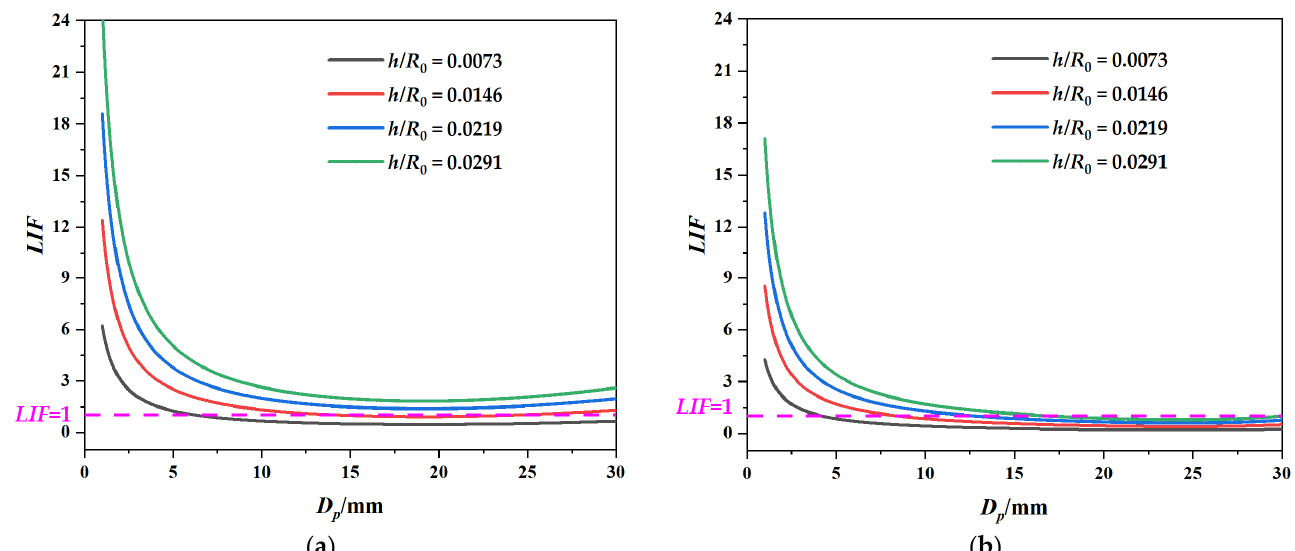
Figure 12. Pressure distribution with different h/R 0 over logarithmic spiral wall surfaces at ( a ) x / R = 1 and ( b ) x / R = 2/3.